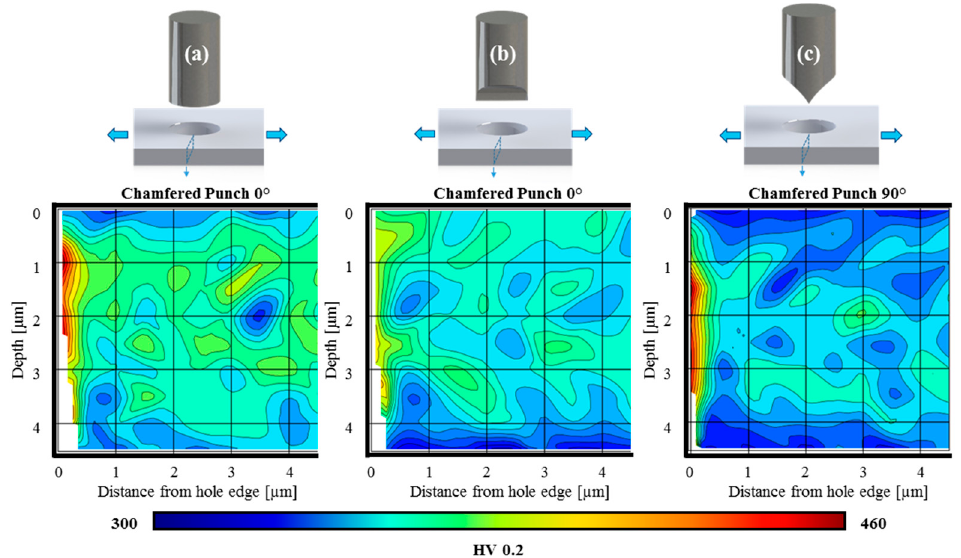
Figure 12. Hardness distribution produced in the S960MC by ( a ) flat punch, ( b ) chamfered punch at 0°, and ( c ) chamfered punch at 90°.